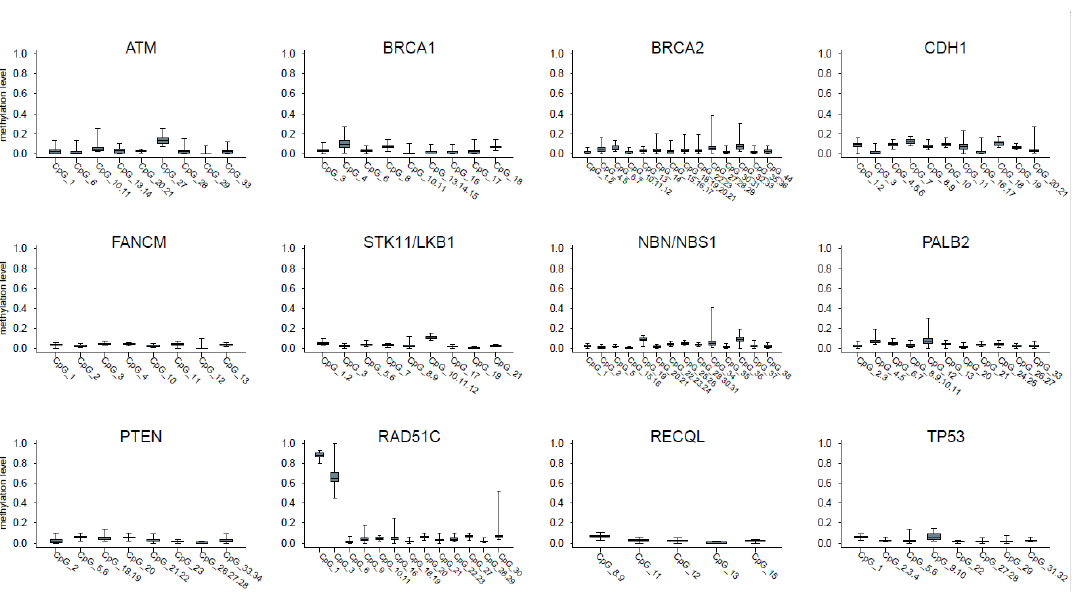
Figure 1. distribution of blood methylation levels of selected CpGs within each promoter. Each panel reports the box plot of the blood methylation levels at the selected CpGs within a single promoter. The boxes indicate the 25th and 75th percentiles of the distribution. The horizontal line inside the box indicates the median and the whiskers indicate the extreme (max and min) values of the blood methylation levels.